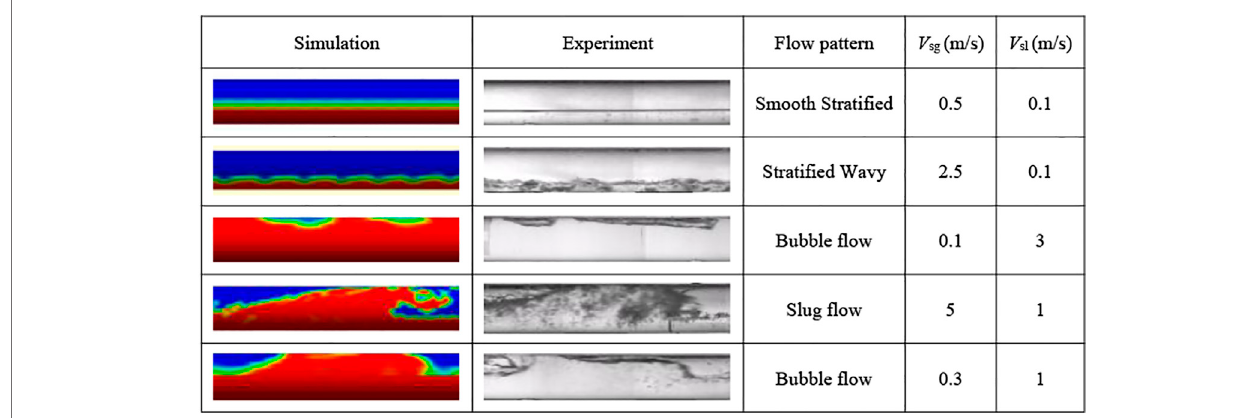
FIGURE 7 | Comparison of simulation and experiments for fi ve kinds of fl ow patterns.